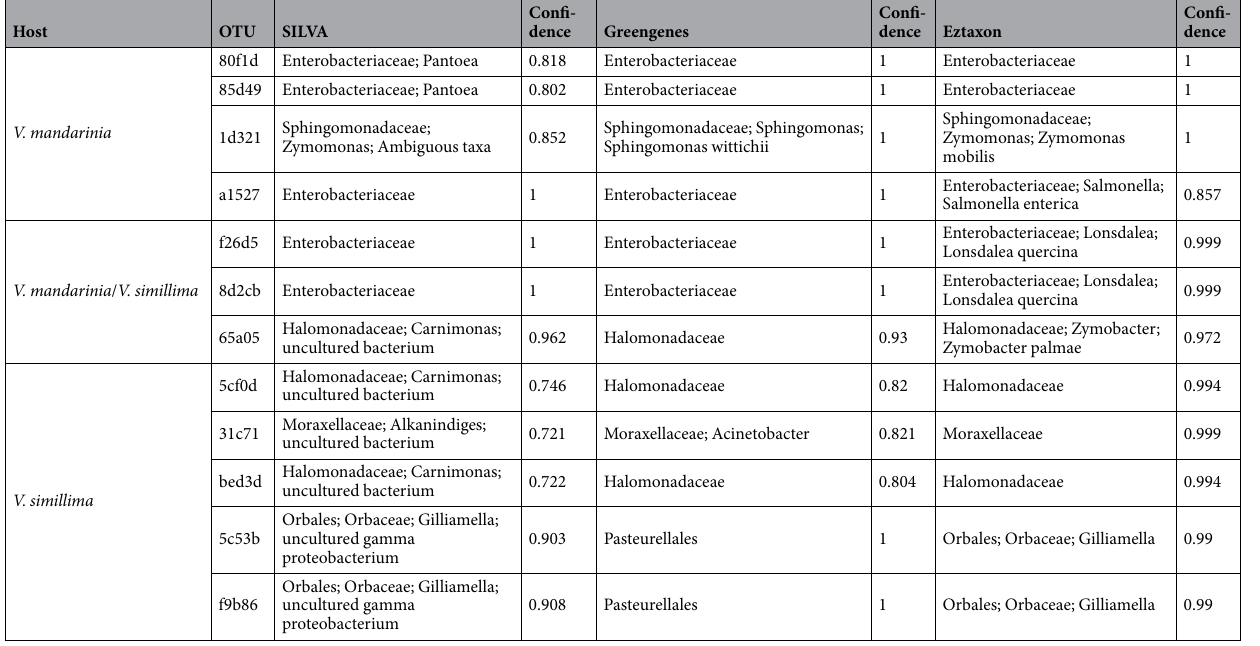
Table 2. Taxonomic classification of core OTUs in hornet gut microbiome based on different 16S rRNA gene databases. Classification of core OTUs using SILVA, Greengenes, and EzTaxon, are shown at deeper levels than the class. Confidence is probability that the OTU was assigned to the represented taxon. The OTU IDs were shortened to the last five